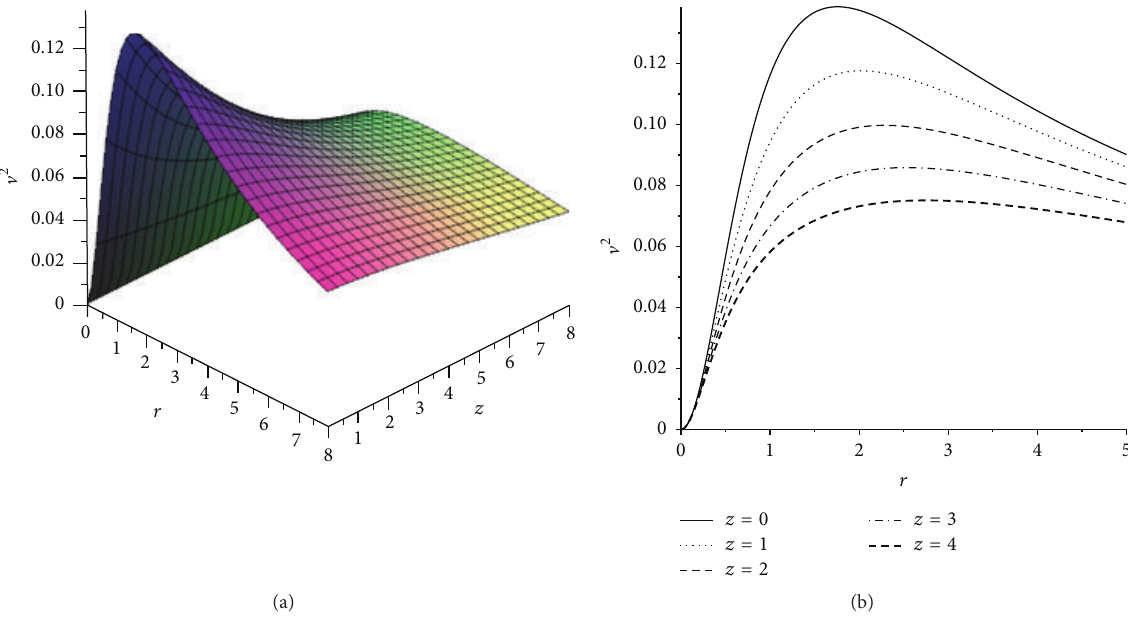
Figure 3: Surface plot of the velocity (a) V 2 0 and 𝑧 -slices of the surface plot of the velocity (b) on the halo as functions depending on 𝑟 and 𝑧 with parameters 𝑎 = 𝑏 0 = 𝑏 1 = 𝑘 = 𝑘 𝜔 = 1 and 𝛽 = 0.75 .